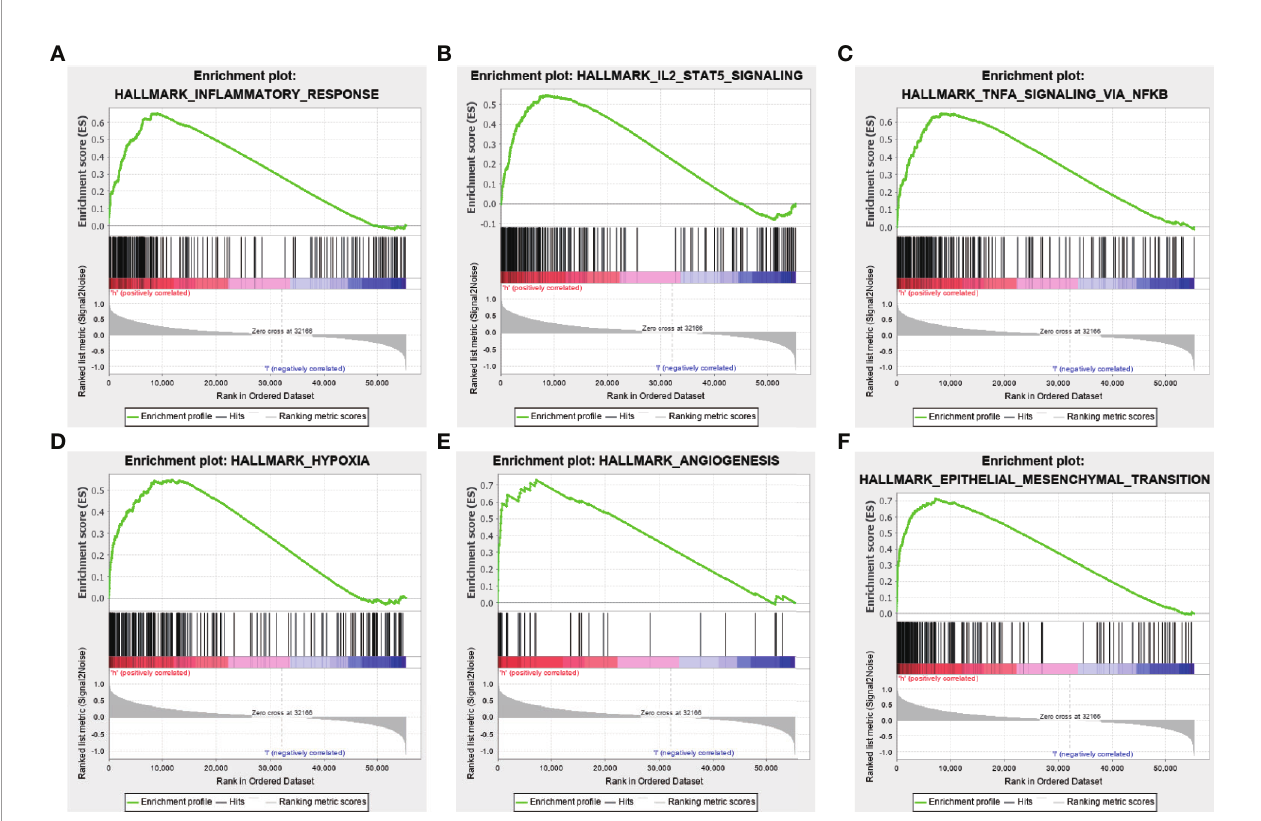
FIGURE 7 | Functional enrichment analysis based on the prognostic model in the TCGA data set. GSEA indicated obvious enrichment of (A) in fl ammatory response, (B) IL 2/STAT5 signaling, (C) TNF a signaling via NF- k B, (D) hypoxia, (E) angiogenesis, and (F) EMT in the high-risk